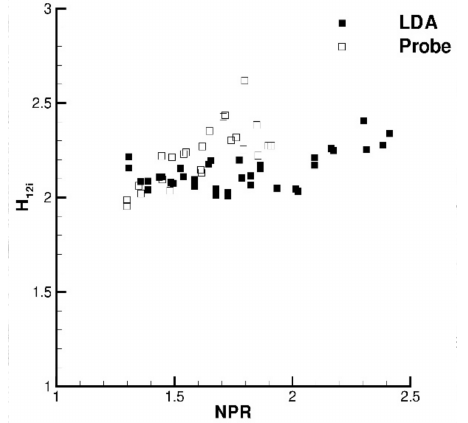
Figure 11. LU48 nozzle exit shape factor H 12 i probe and LDA